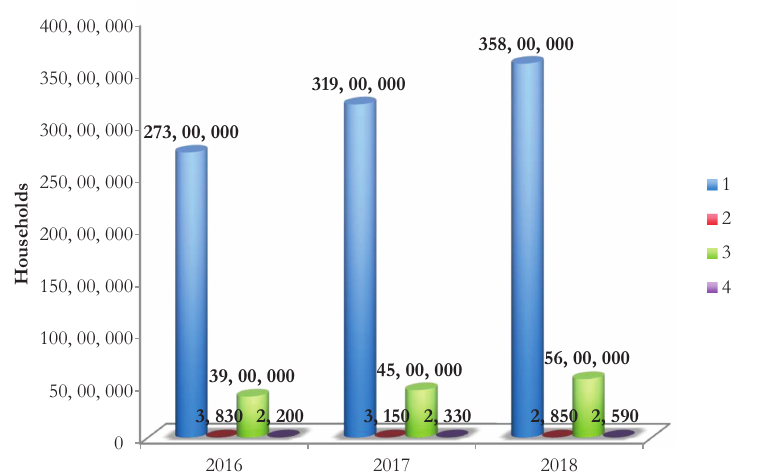
Figure 2. Number of VBSP borrowers and borrowers